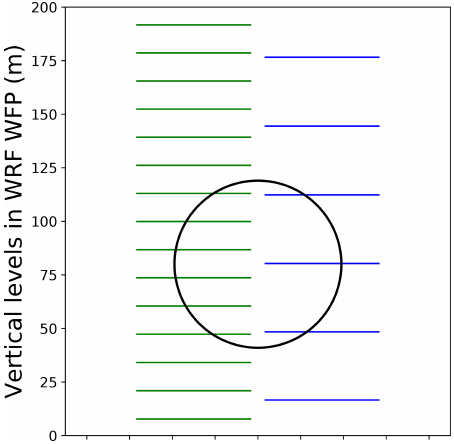
Figure 2. Schematic of the two vertical grids tested and where they typically intersect the turbine rotor layer (black circle): the ∼ 10m grid ( dz10 ) on the left in green and the ∼ 30m grid ( dz30 ) on the right in